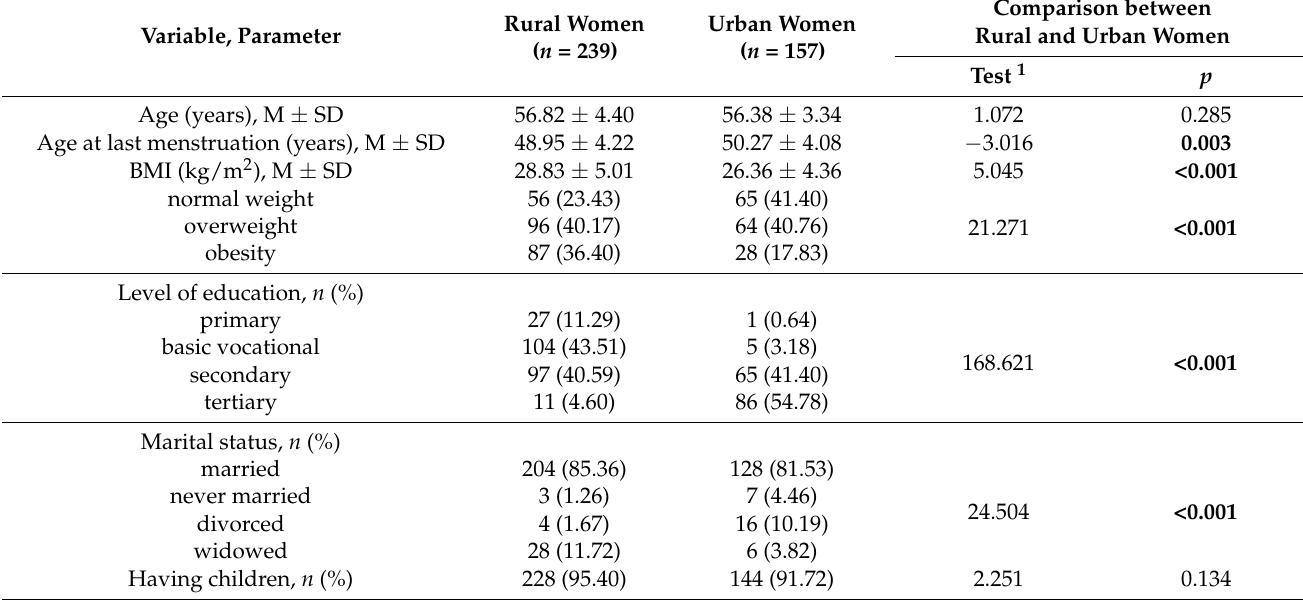
Table 1. Study group characteristics.